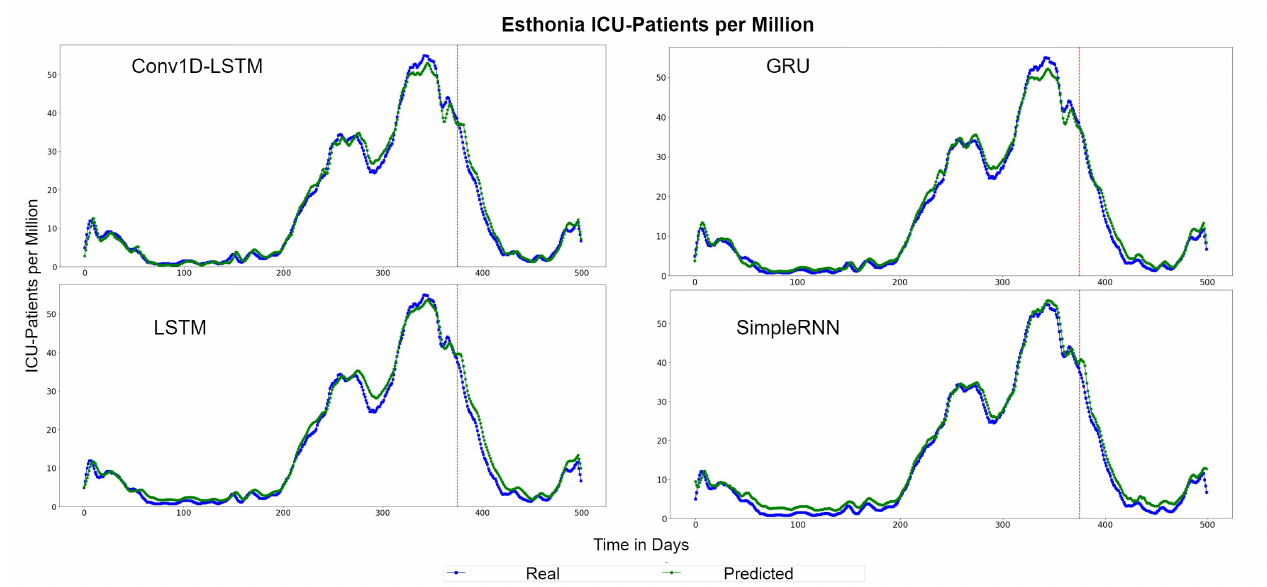
Figure 16. Estonia ICU-Patients per million real (blue line) and predicted (green line) values for each method, using the training, validation and test datasets. The red line divides the train-validation (right size) and the test (left side)